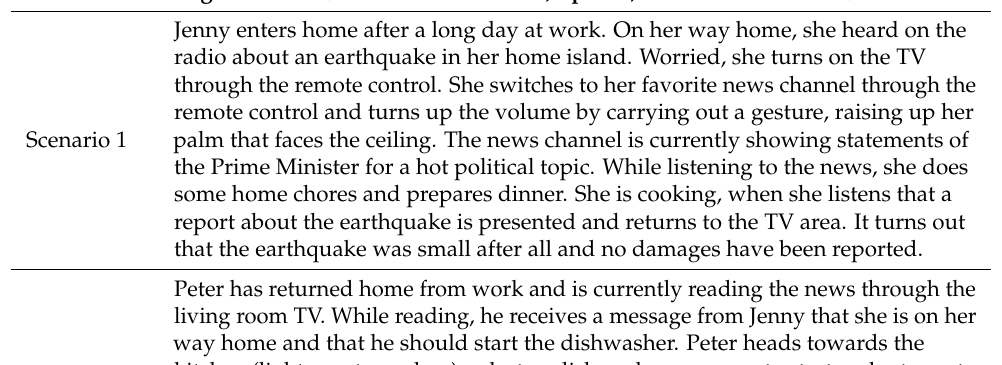
Table 3. Evaluation